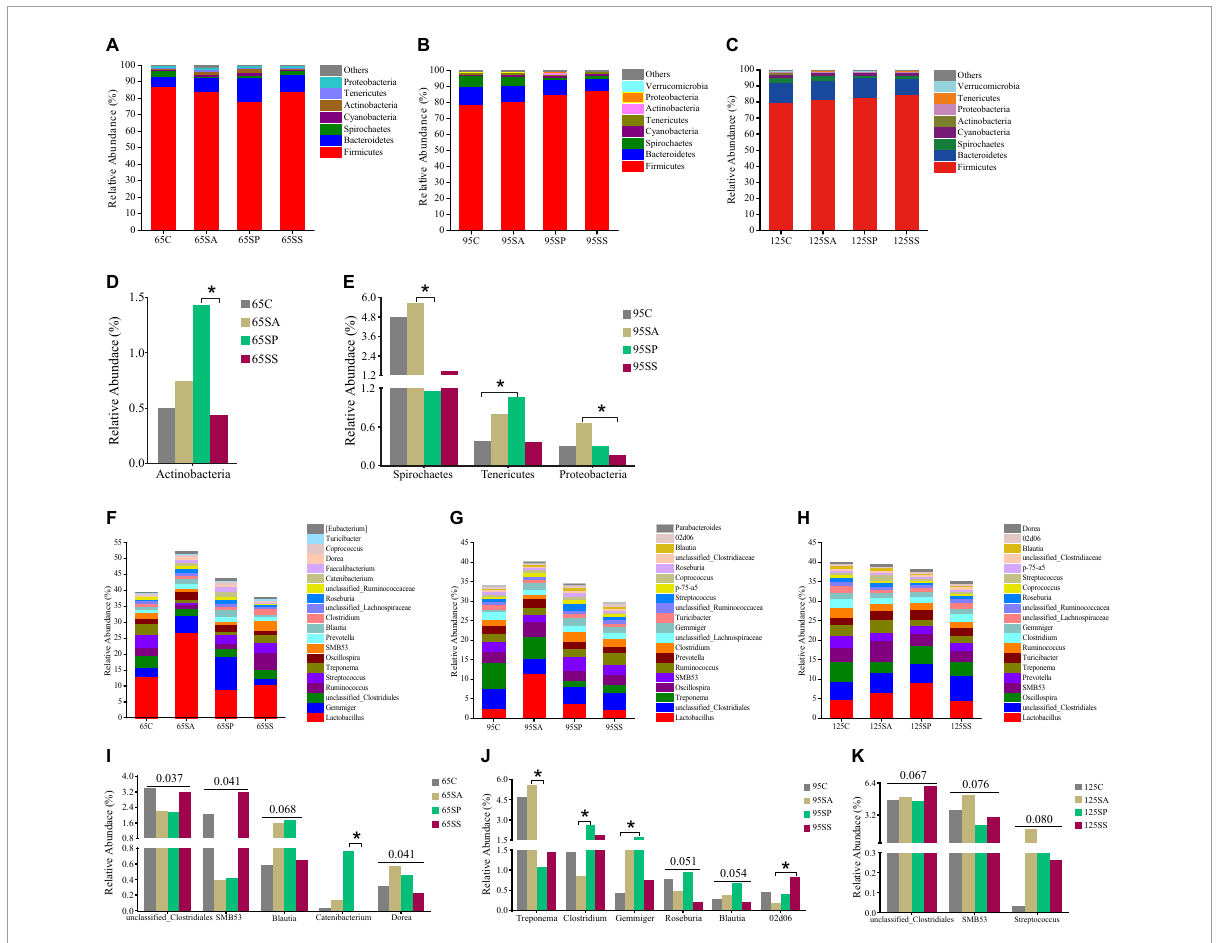
FIGURE2 Relative abundance of colonic microbiota at phylum level (relative abundance > 0.1%) (A–C) and genus level (the top 20 genera) (F–H) of offspring pigs. The significant changes of phyla at 65 (D) and 95 (E) days of age and genera at 65 (I) , 95 (J) , and 125 (K) days of age are presented. The values are expressed as the median. Statistical differences are calculated by the Kruskal-Wallis test: Significance is considered at a P -value < 0.05 and the tendency is considered at a P -value between 0.05 and 0.1. Asterisk represents P < 0.05. 65C, 95C, and 125C, sow fed with basal diet; 65SA, 95SA, and 125SA, sow fed with antibiotic; 65SP, 95SP, and 125SP, sow fed with probiotics; 65SS, 95SS, and 125SS, sow fed with synbiotics.